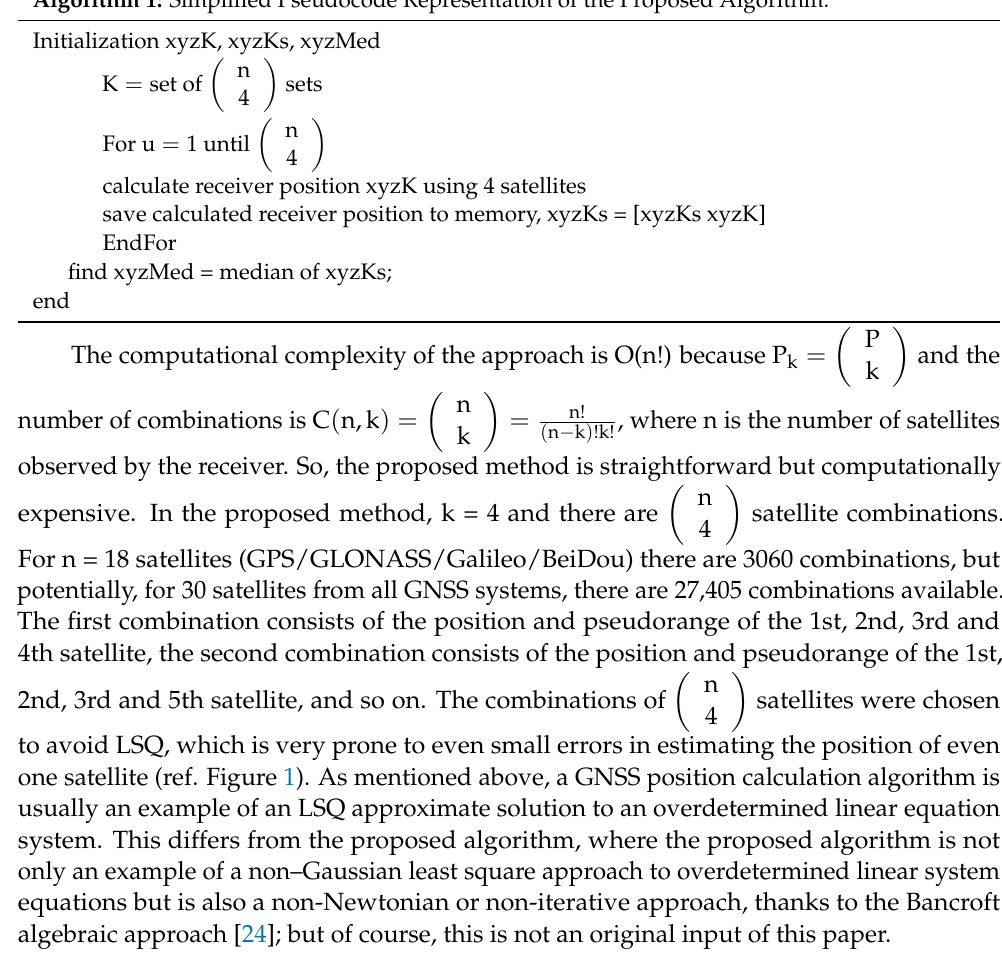
Algorithm 1: Simplified Pseudocode Representation of the Proposed